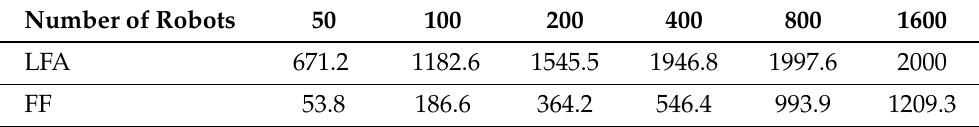
Table 2. Targets found when increasing the number of robots— Scenario 1